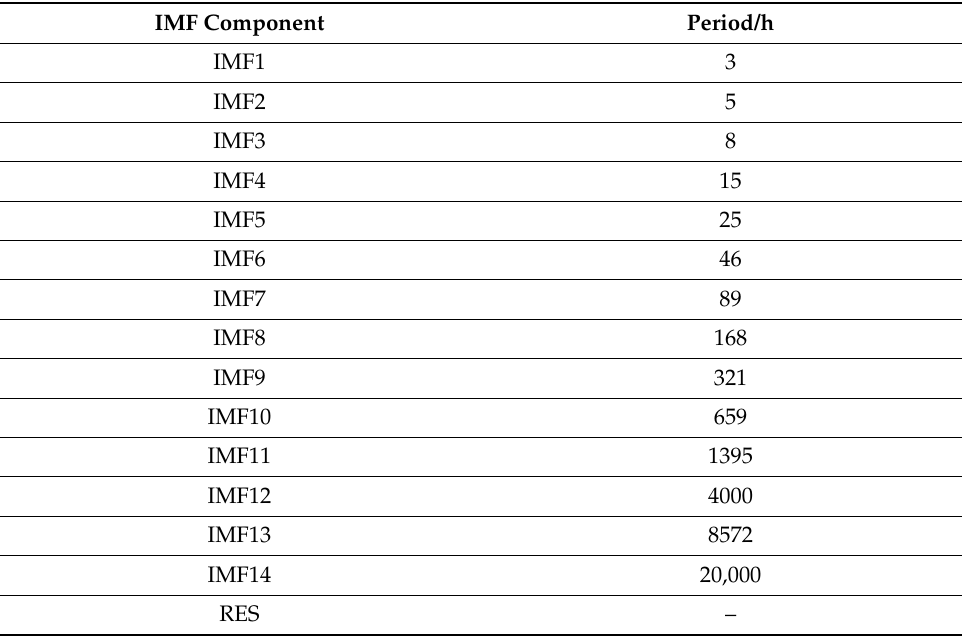
Table 1. The period of each IMF component of PM2.5 concentration.